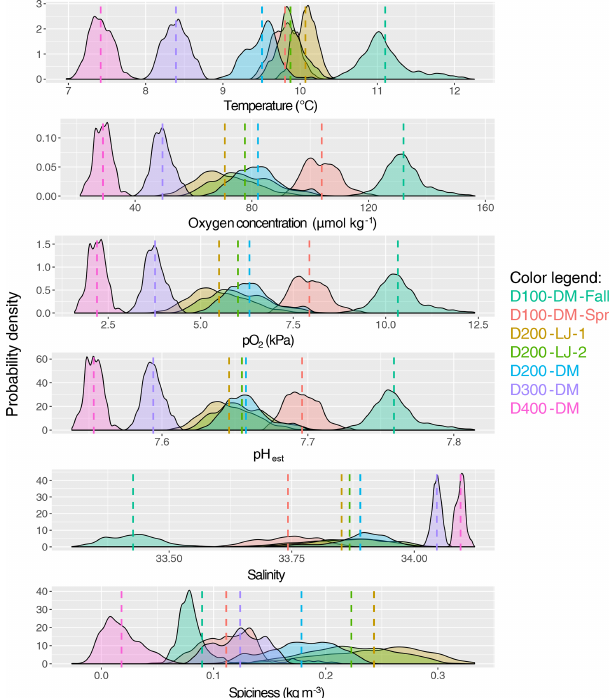
Figure 4. Mean and variance of near-seafloor temperature, oxygen concentration, oxygen partial pressure, pH est , salinity, and spici- ness. The probability density of data collected for each deployment is shown, with the color of the data distributions corresponding to each deployment (as indicated in the color legend). The mean is in- dicated with a dotted line in the same color, and exact values are given in Table 1; pH est is estimated pH calculated using empirical relationships from Alin et al. (2012). Sampling dates for each de- ployment are given in Table